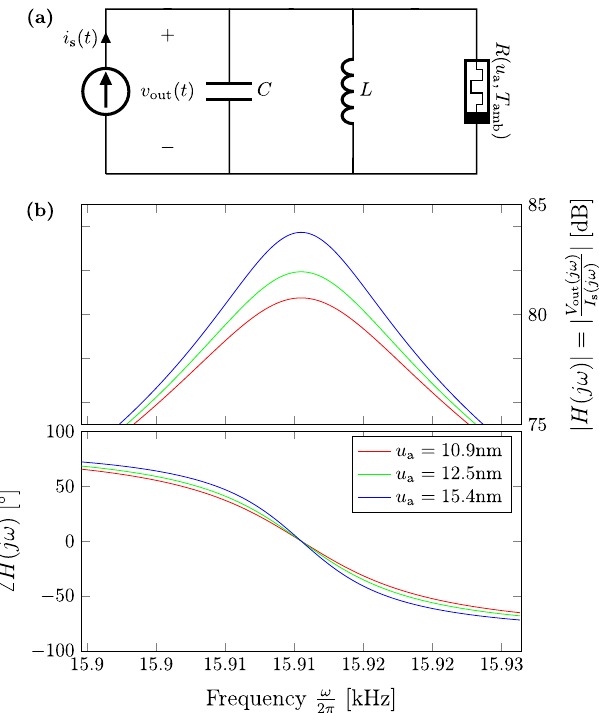
Figure 8. ( a ) Application in re-configurable electronics. Passive tunable RLC passband filter exploiting a PCM device in its read region via R m ( u a , T int ) . ( b ) Bode plots of the transfer function H ( j ω) parametrized on the final resistance values reached by following the DRMs in Fig.